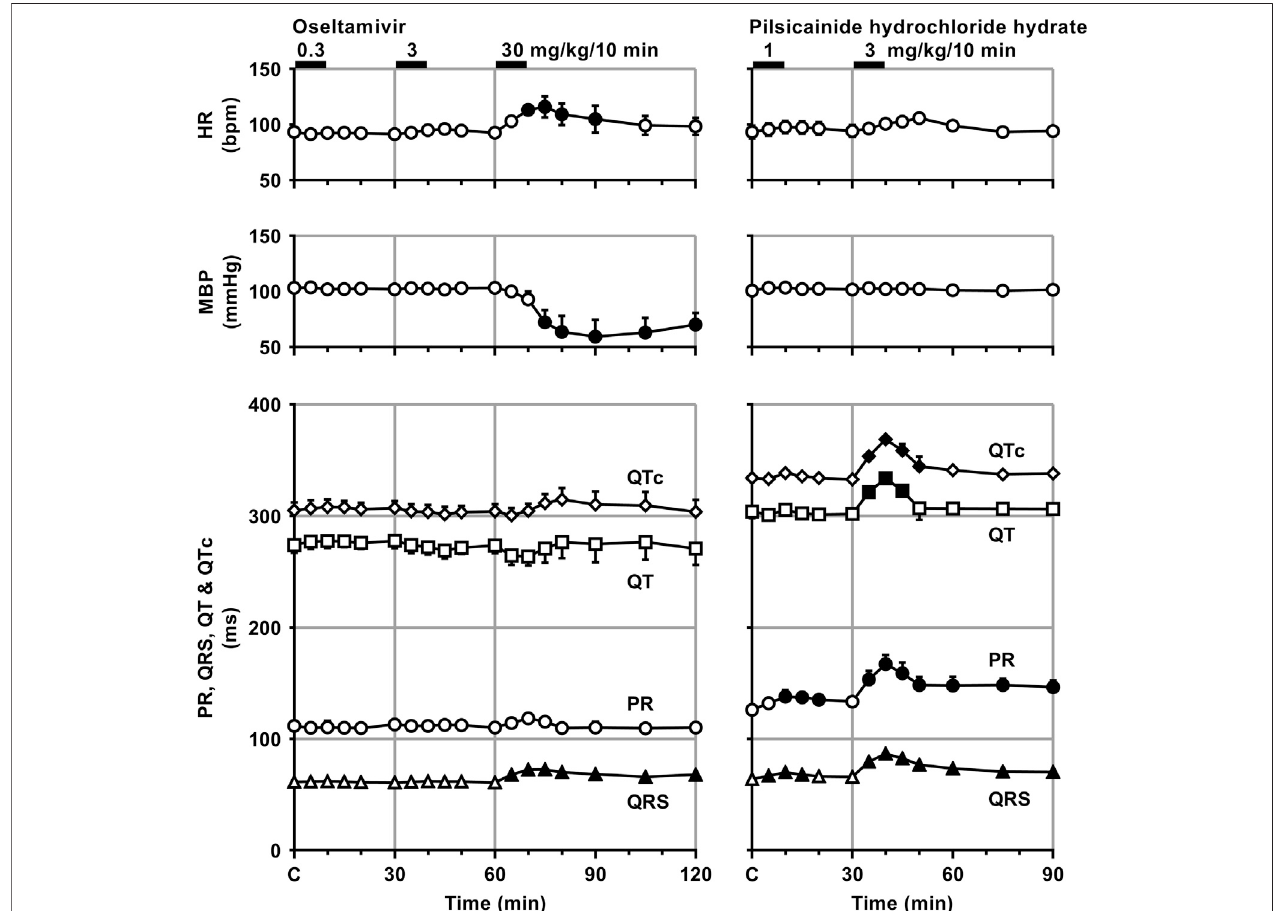
FIGURE 2 | Time courses of changes in the heart rate (HR), mean blood pressure (MBP), PR interval (PR), QRS width (QRS), QT interval (QT) and QTc after the administrationsofoseltamivir (left) andpilsicainidehydrochloridehydrate (right) .QTintervalwascorrectedwithVandeWater ’ sformula:QTc (cid:1) QT − 0.087 × (RR − 1,000) with RR given in ms (Van de Water et al., 1989). Data are presented as mean ± S.E.M. (n (cid:1) 4 for each drug). Closed symbols represent signi fi cant differences from their corresponding pre-drug basal control value (C) by p < 0.05.